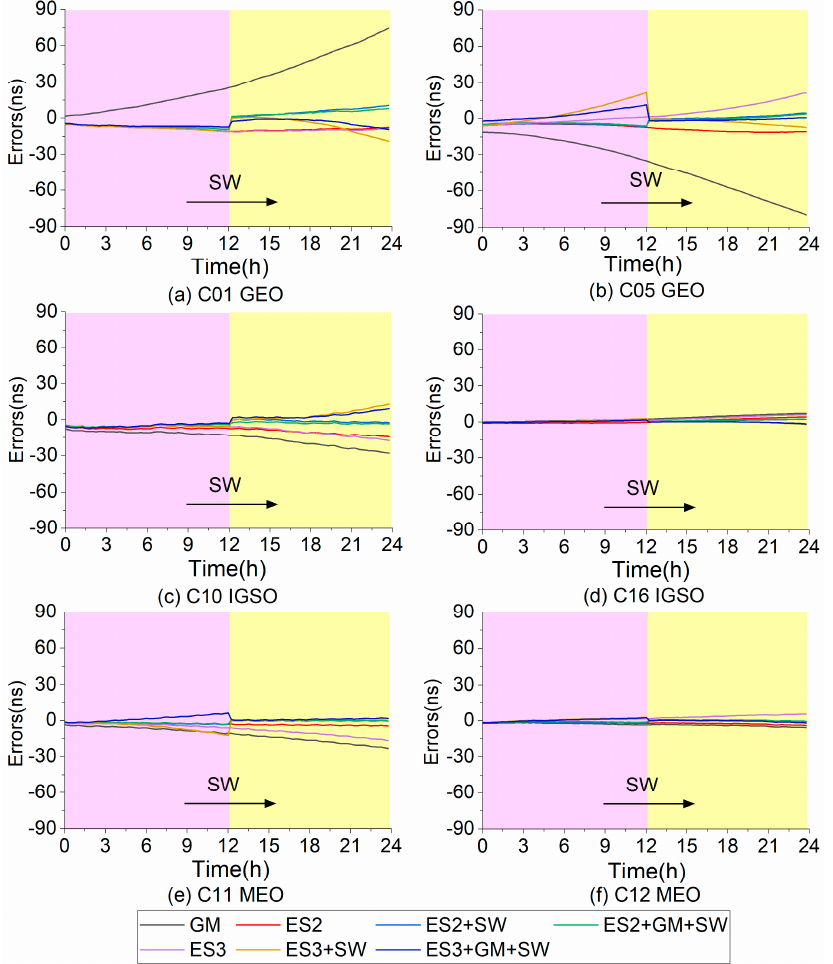
Figure 10. Variation diagram of 24 h satellite clock bias forecast errors using different models: ( a ) is the changes of the C 01 SCBs forecast, ( b ) is the changes of the C 05 SCBs forecast, ( c ) is the changes of the C 10 SCBs forecast; ( d ) is the changes of the C 16 SCBs forecast, ( e ) is the changes of the C 11 SCBs forecast, and ( f ) is the changes of the C 12 SCBs forecast.